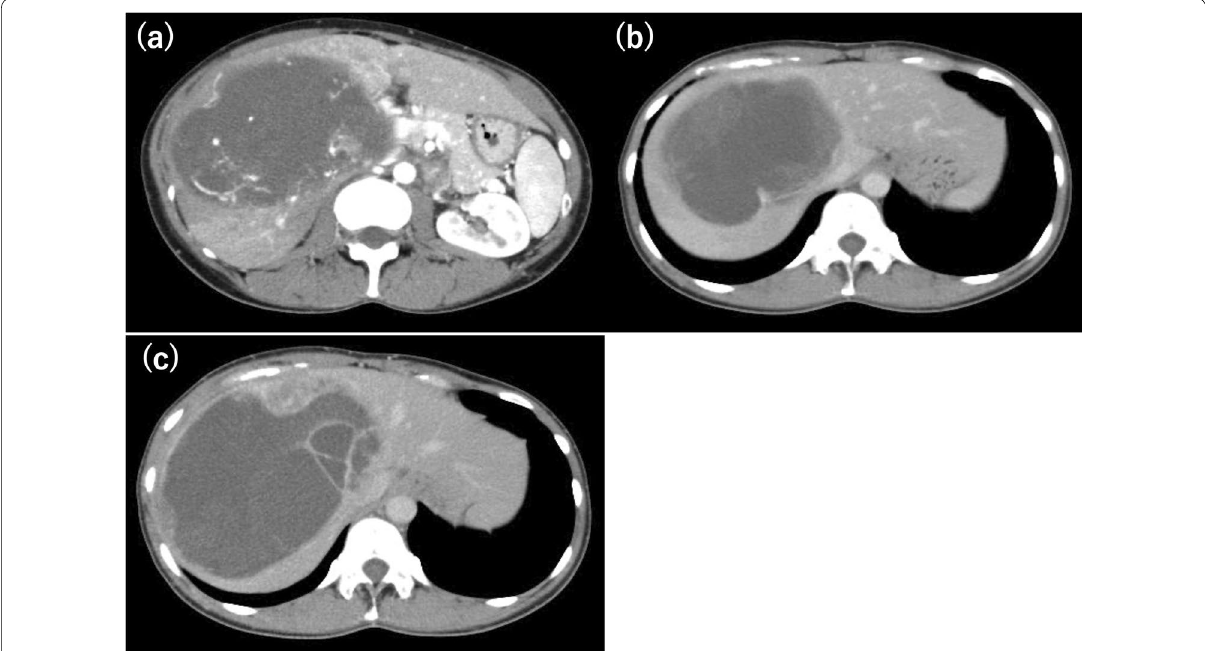
Fig. 1 a and b Computed tomography showing a well-defined cyst. c At the time of exacerbation of abdominal pain, the tumor grows and its solid component is